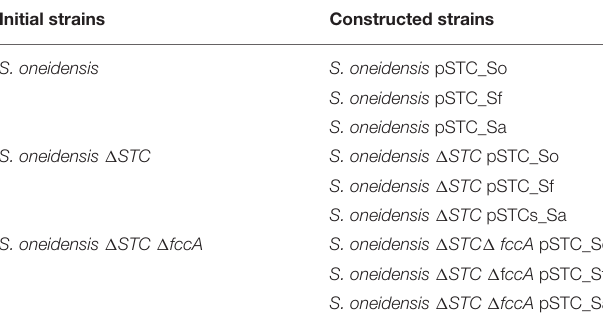
TABLE 1 | Strains of S. oneidensis used in this